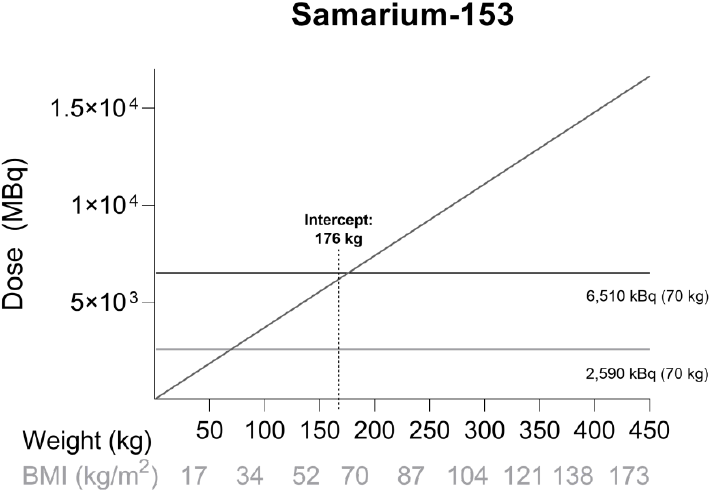
Figure 2. Dose simulation for samarium-153 ( 153 Sm) at 37 kBq/kg. The black horizontal line represents the recommended dose for a 70 kg patient (37 kBq/kg), while the gray horizontal line represents the maximum tolerated dose for a 70 kg patient (93 kBq/kg). The BMI was calculated for a patient with average height (1.70 m). The intercept at 176 kg shows the weight at which the registered dose is equal to the maximum tolerated dose when administered to a 70 kg patient. This corresponds to a patient with a BMI of 61 kg/m 2 .